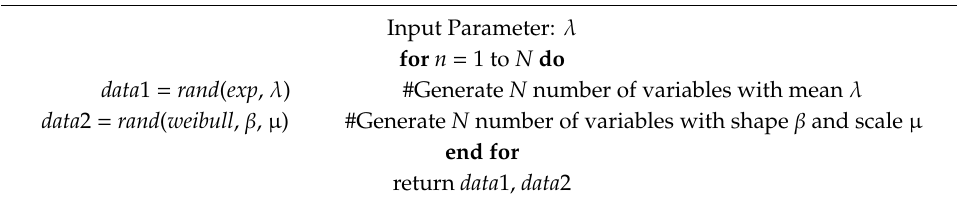
Algorithm 1: Exponential and Weibull Data